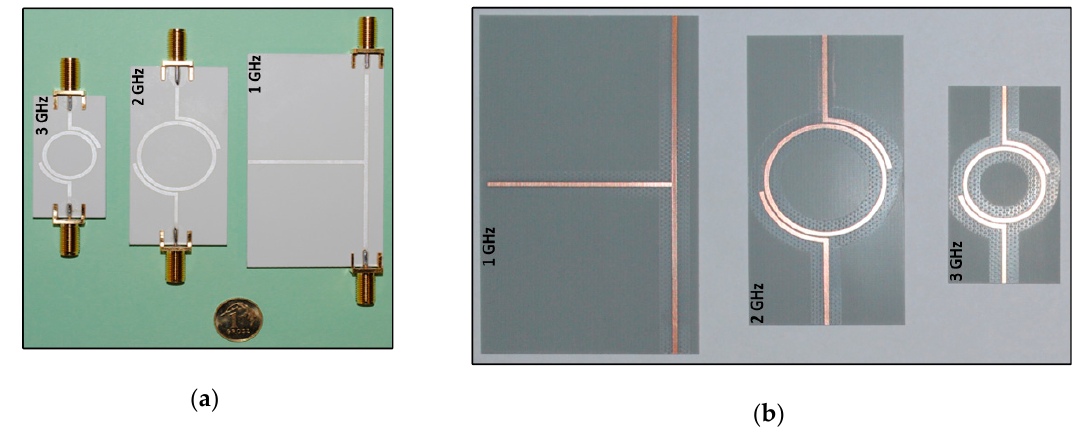
Figure 11. Test resonators: ( a ) On LTCC substrate; ( b ) On PCB substrate.